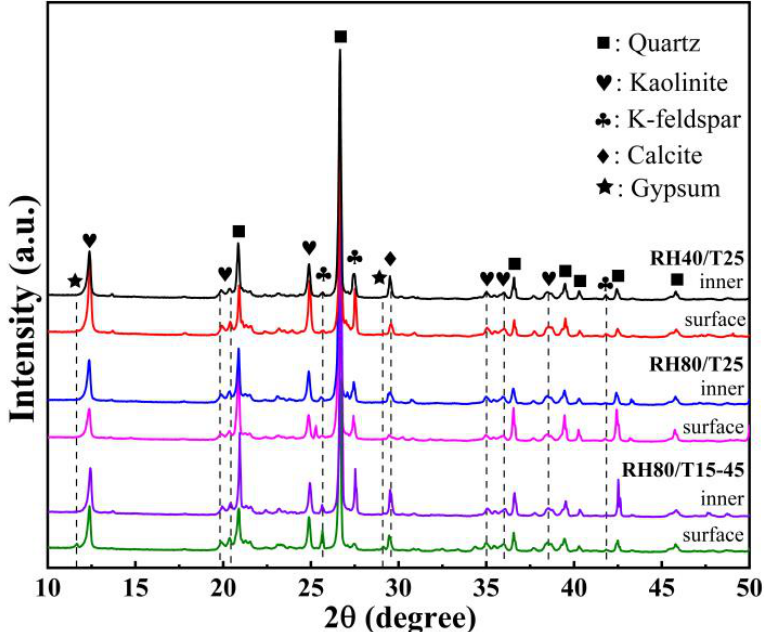
Figure 9. Mineralogical composition of sandstone specimens after weathering tests.